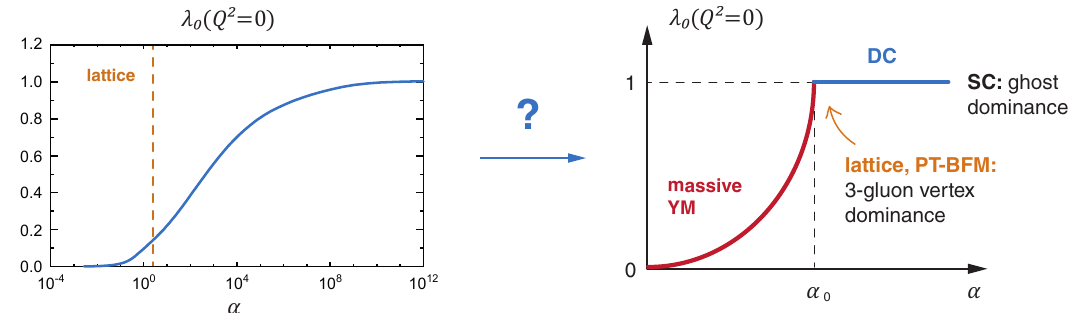
Figure 6: Left: Largest eigenvalue of the homogeneous BSE for the ghost-gluon ver- tex, which only for the scaling solution α → ∞ satisfies λ